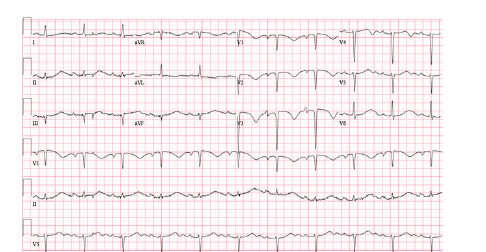
Figure 1: Admission ECG: 1st-degree heart block, with QTc 689 ms.